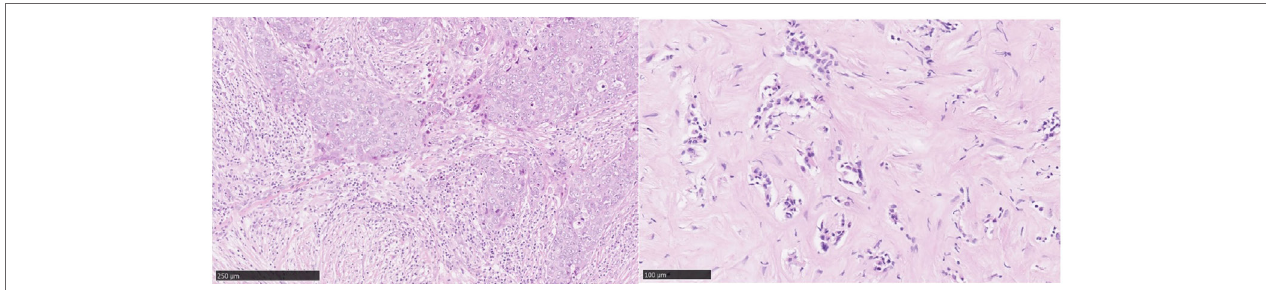
FiGURe 3 | Tumor-infiltrating lymphocytes (TILs): primary versus metastatic disease. Case study: breast primary with high number of TILs (left), pleural metastasis with no TILs (right). Magnification 100 × (left), 200 ×